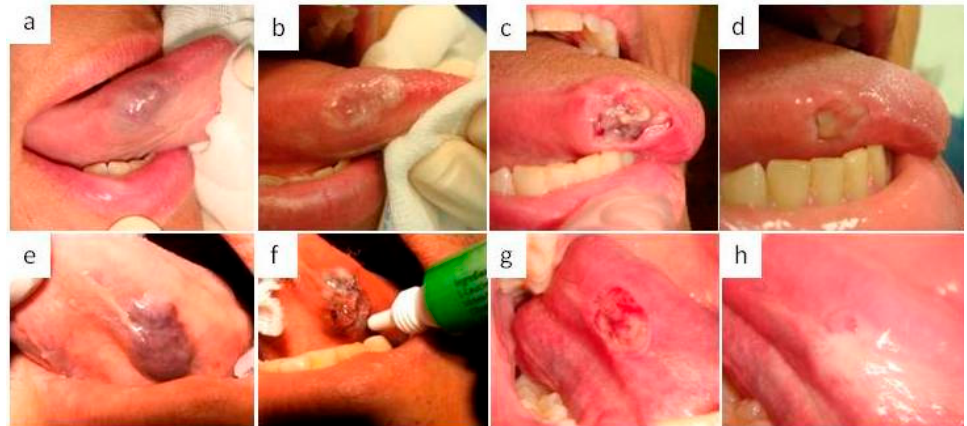
was detectable in the patient not receiving Aminogam ® gel ( d ), while complete wound healing was observable in the treated patient ( h ).